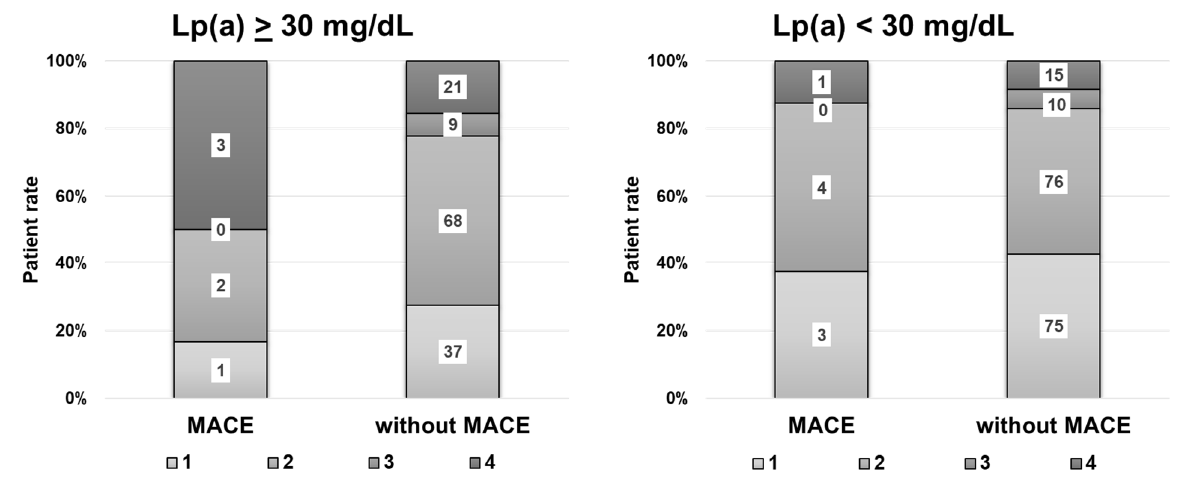
Figure 4. Proportion of patients with or without MACE in the first year after surgery. 1—Segmental lesion of the spacecraft without calcinosis, 2—diffuse lesion without calcinosis, 3—segmental with calcification, 4—diffuse with calcinosis.